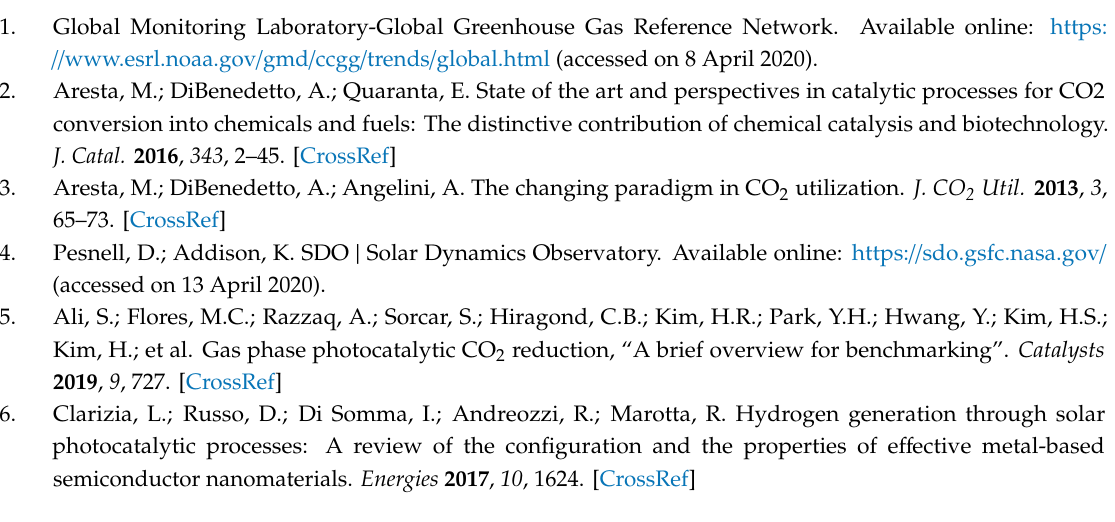
Figure S1: Comparison of CP-Fe 2 O 3 XRD patterns with HEM-Cu / Fe-1 (a) and CP-Cu / Fe-1 (b) along with peak positions for reference di ff raction patterns. Figure S2: High resolution XP spectra of all the samples. (a) C-Cu 2 O sample: (a1) Cu 2p 3 / 2 spectral region, (a2) Cu LMM Auger transition and (a3) O1s spectral region. (b) S-Cu 2 O sample: (b1) Cu2p 3 / 2 spectral region, (b2) Cu-LMM Auger transition and (b3) O1s spectral region. (c) C-In 2 O 3 sample: (c1) In3d spectral region, (c2) In MNN Auger transition and (c3) O1s spectral region. (d) S-In 2 O 3 sample: (d1) In3d spectral region, (d2) In MNN Auger transition and (d3) O1s spectral region. Fe2p spectral region for (e1) C-Fe 2 O 3 and (e2) S-Fe 2 O 3 . Figure S3: H 2 evolution with time by using CP-Cu / In mixed oxides under VIS light